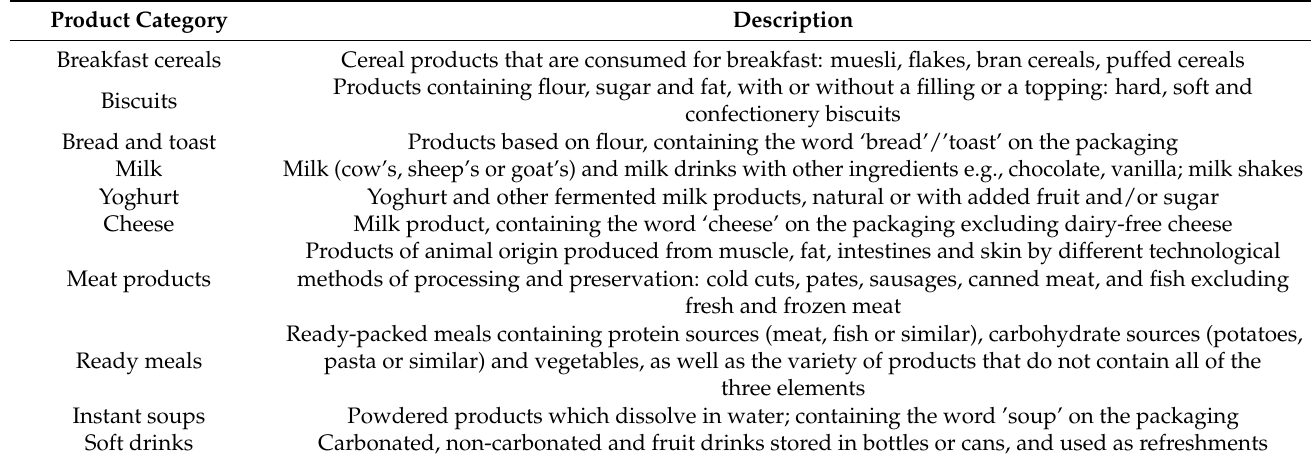
Table 1. The description of the food categories included in the 2012 survey and 2020 survey. Product Category Description Breakfast